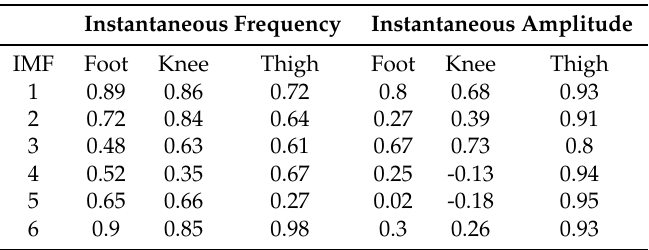
Table 5. The correlation coefficients R s of each decomposed IMF instantaneous frequency and amplitude between hip and leg joins (thigh, knee, foot) of whole gain